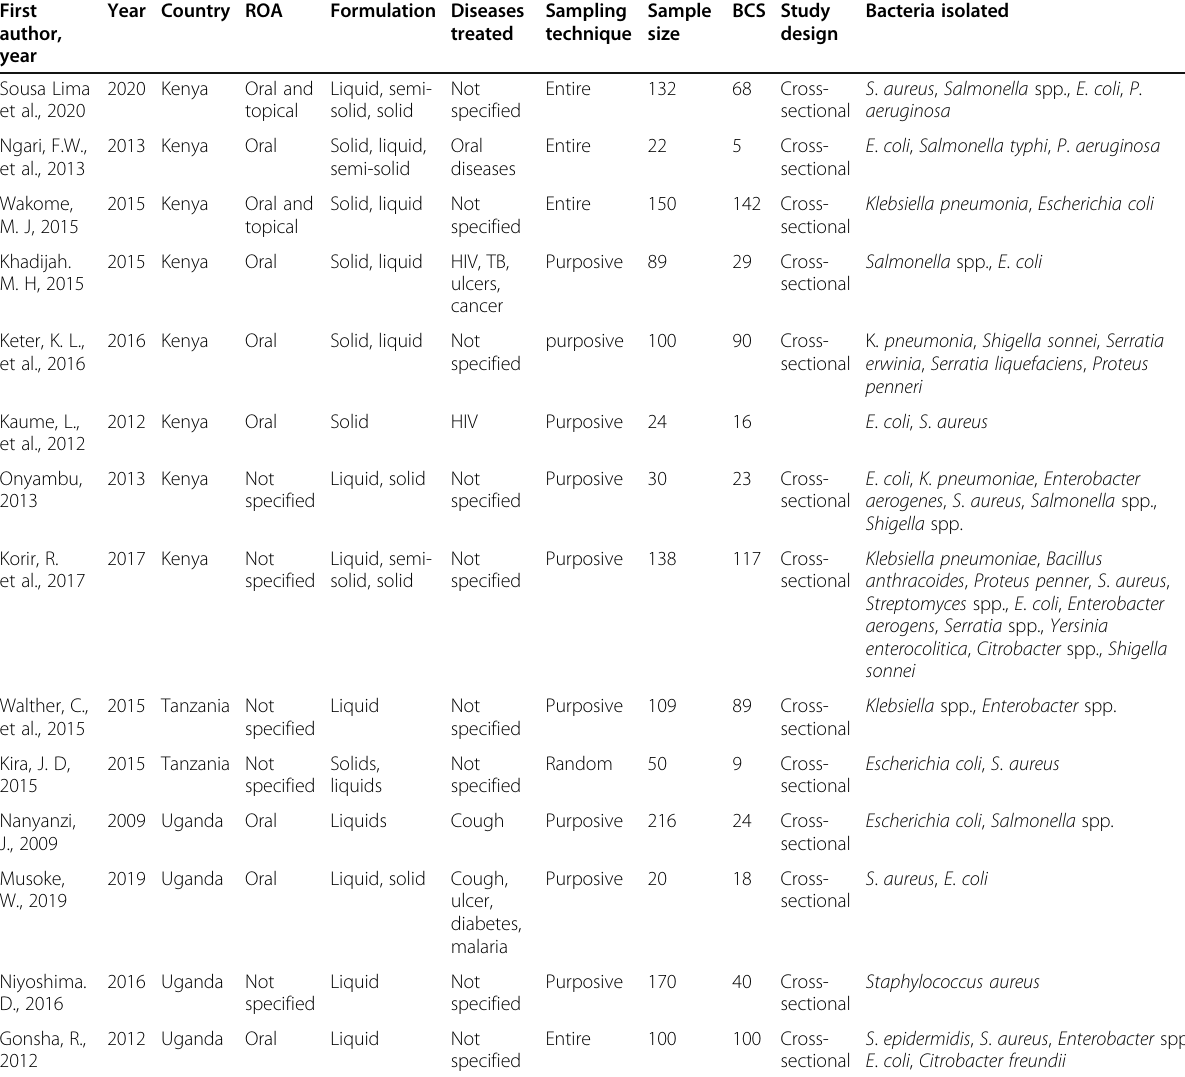
Table 3 Characteristics of the articles concerning bacterial contamination of HM in E. Africa that were reviewed in this